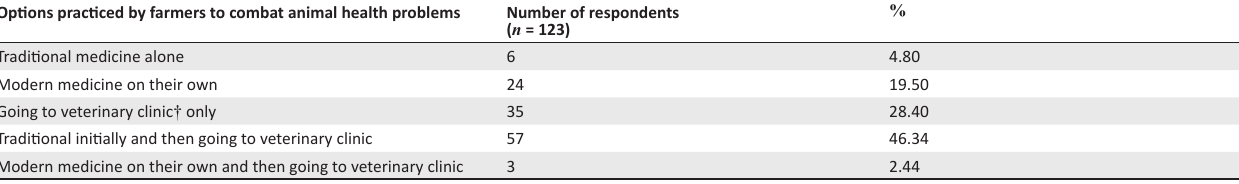
TABLE 1: Accustomed practices undertaken by farmers to combat animal health problems. Options practiced by farmers to combat animal health problems